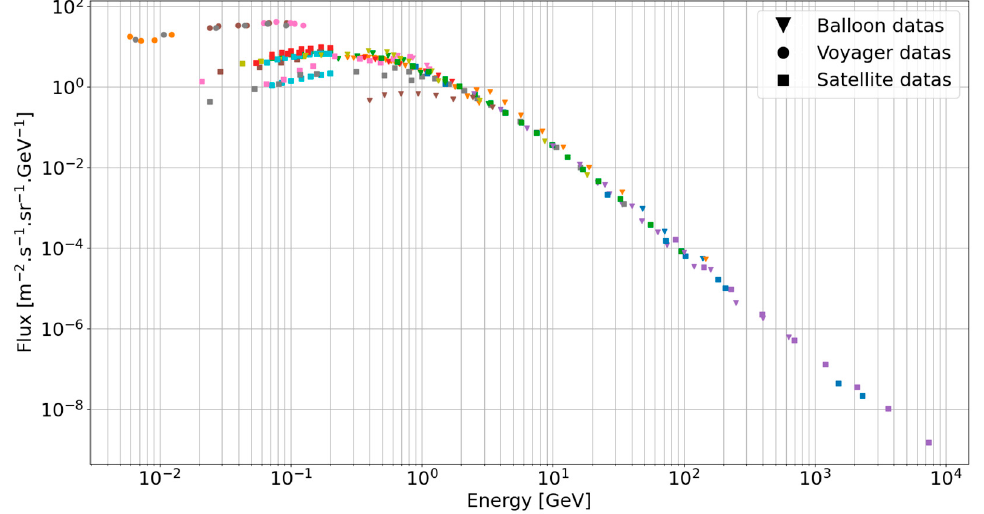
Figure 7. Proton spectrum based on data from several instruments on Voyager, satellite or balloon extracted from the CRDB. Each color is a different experiment.